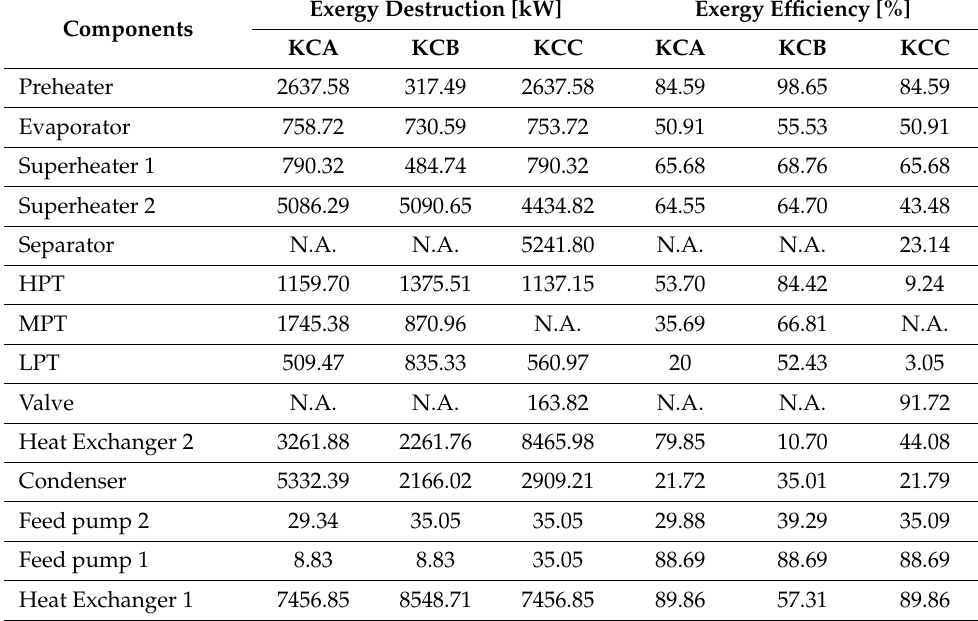
Table 11. Exergy analysis of components in Kalina